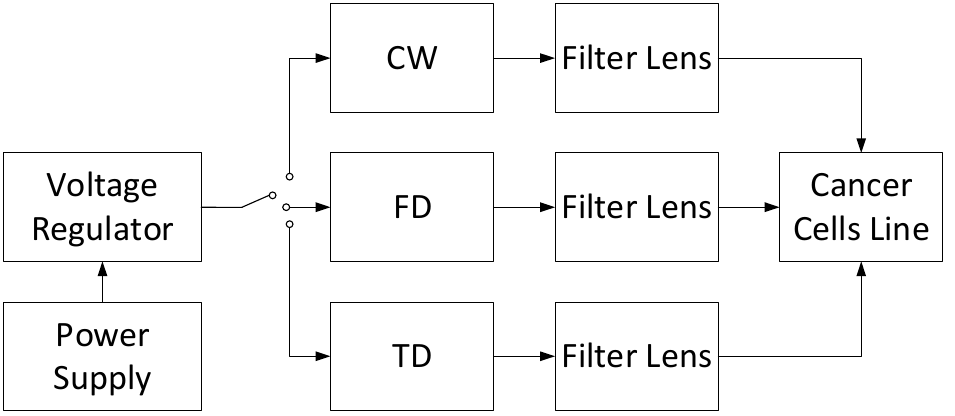
Figure 7. Combined CW, FD, and TD light sources instrumentation.